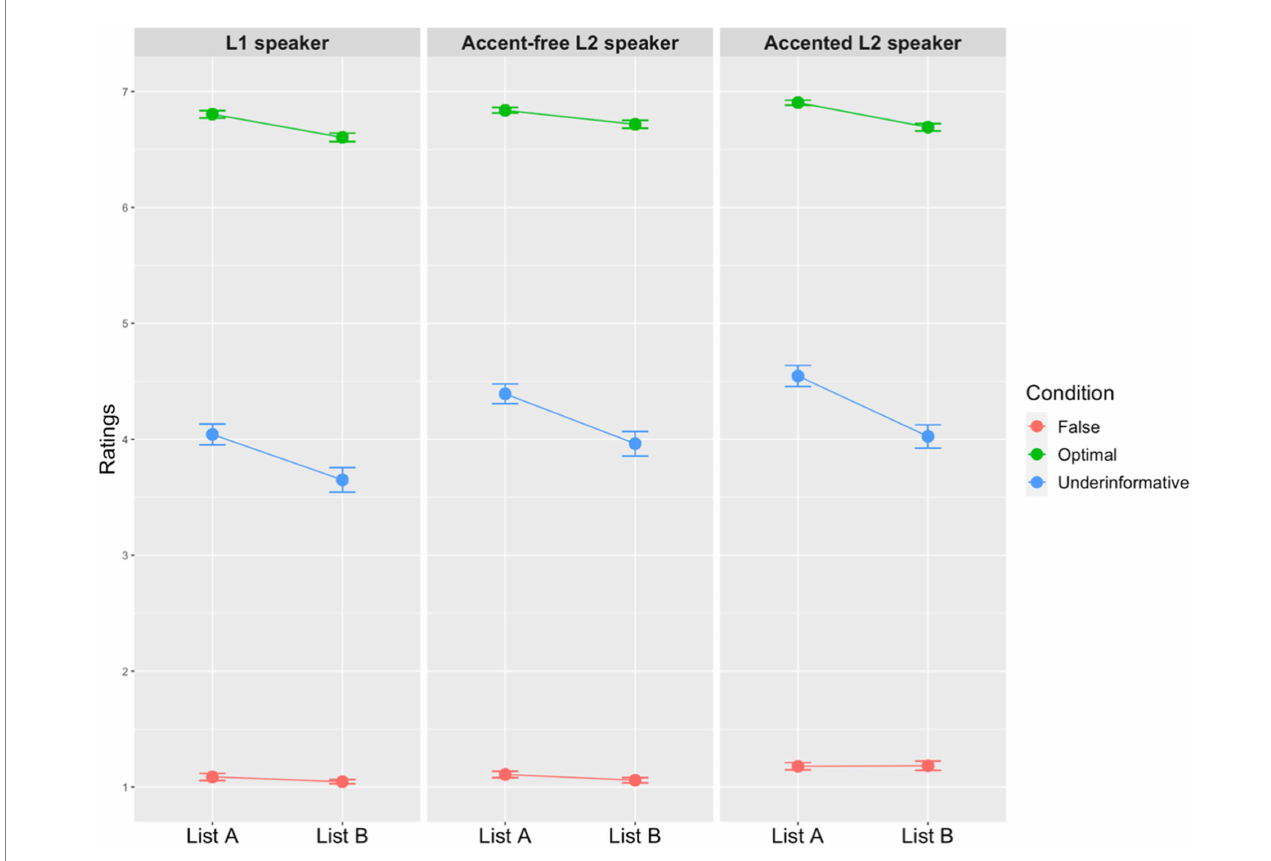
FIGURE 4 Mean ratings of all conditions for ad hoc implicature with points and standard error bars (the y -axis represents the acceptability of sentences. The higher the ratings are, the more acceptable the sentences